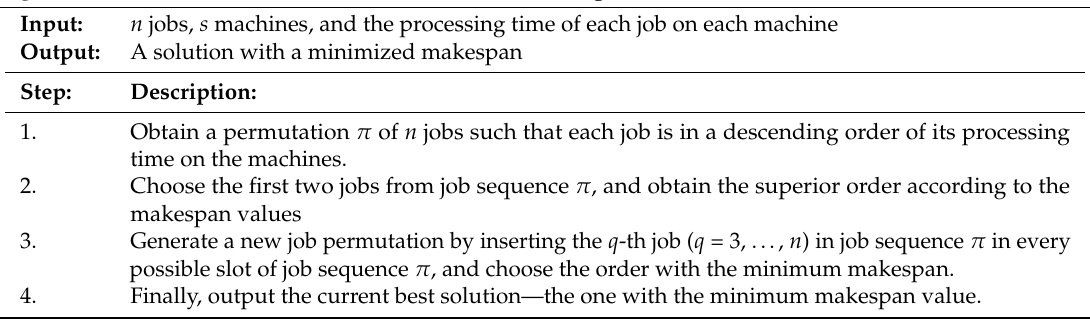
Algorithm 1 Standard Nawaz–Enscore–Ham (NEH)